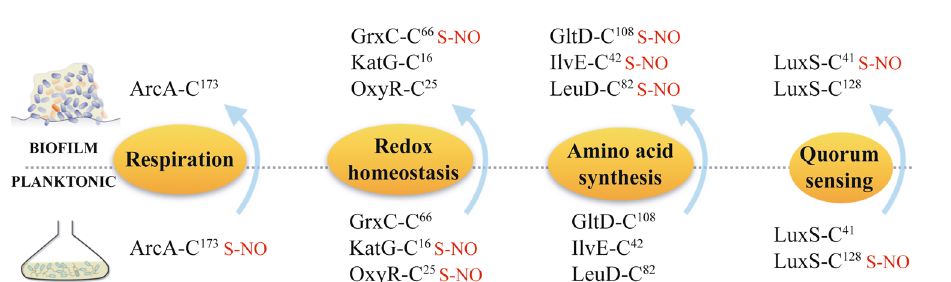
Fig. 4 Cysteines with the highest S- nitrosylation fold changes or differentially S- nitrosylated in both aerobic and anaerobic conditions. These cysteines are in proteins involved in known bio fi lm-associated phenotypes, including respiration, redox homeostasis, amino acid synthesis, and quorum